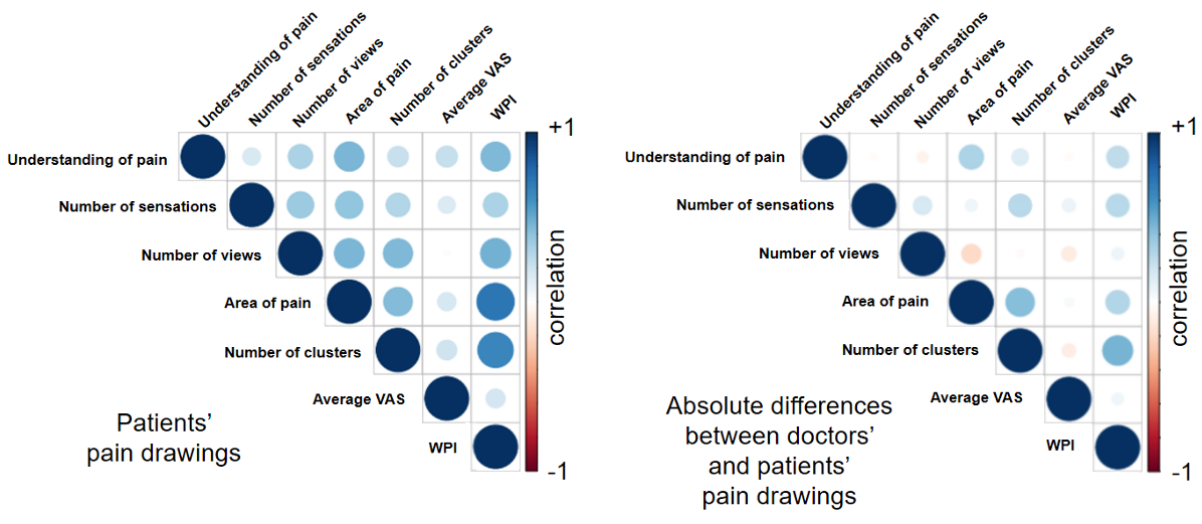
Figure 5. Factors with the potential to influence doctors’understanding of the patients. The left image shows correlations of pain drawing characteristics extracted from the patients’ drawings, whereas the right image is based on absolute differences of those characteristics between patients’ and doctors’ drawings. Correlation strength is encoded in color brightness and circle size. Blue color indicates positive values and red color indicates negative values. Both the areas of pain (in percent body area) and the widespread pain index (WPI) showed significant correlations with the doctors’ understanding of pain. VAS: visual analog